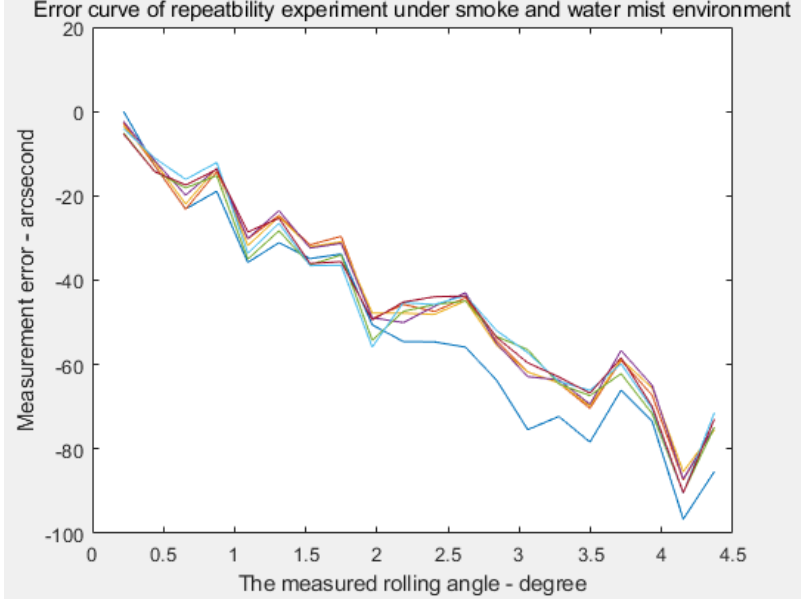
Figure 26. Error curves of repeatability experiment under smoke and water mist environment.